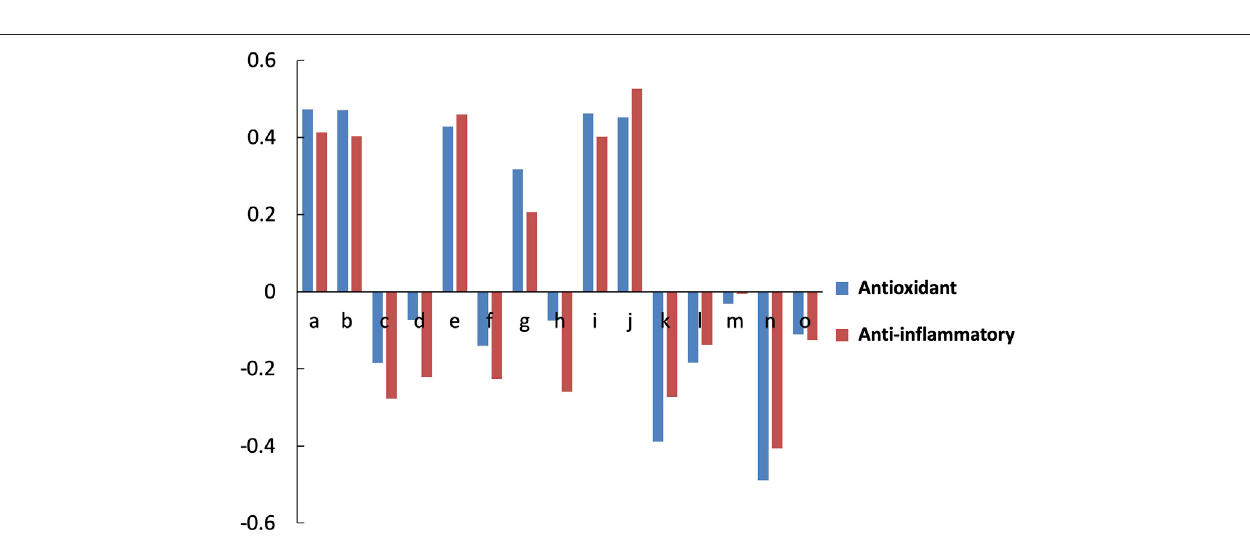
FIGURE 5 | Analysis of the spectrum-effect relationship: the correlation coef fi cient between the content of chemical compounds and bioactivity.